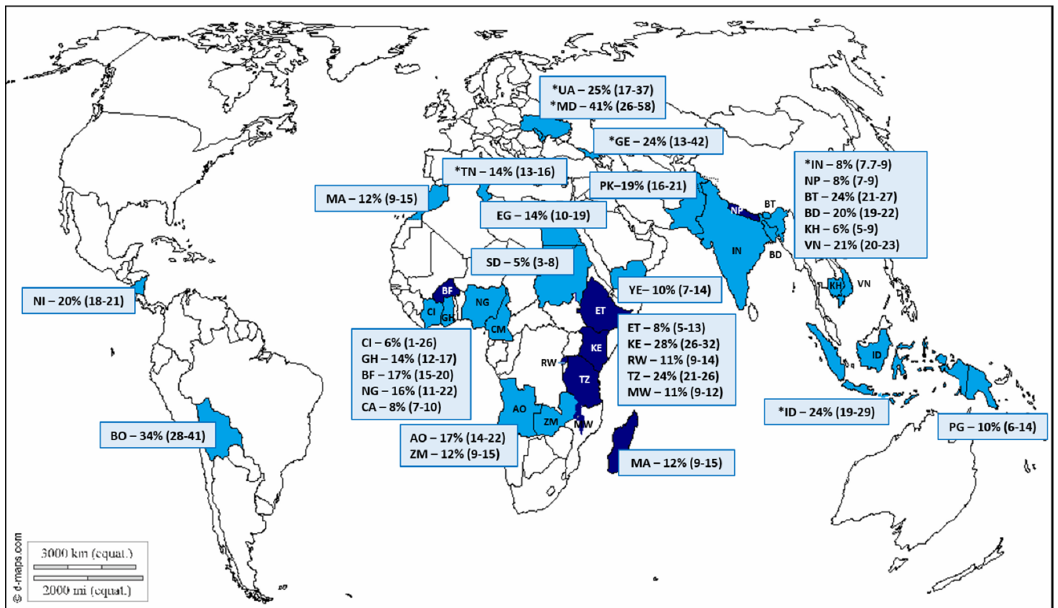
Figure 2. The world map indicating the low-income countries (LIC; dark blue) and lower-middle-income countries (LMIC; light blue) that are represented by the norovirus studies. The average norovirus prevalence and 95% confidence interval (95% CI) is indicated for each country. Countries are identified by two-letter International Organization for Standardization (ISO) codes, and the study references are indicated in brackets. AO, Angola [23]; BD, Bangladesh [28,29,37–39]; BO, Bolivia [40];